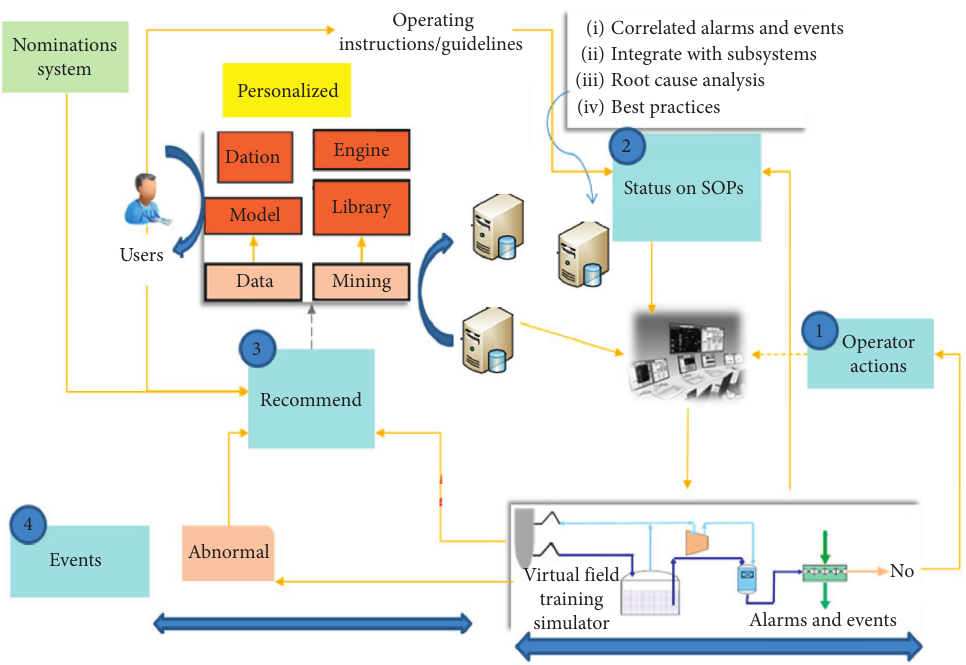
Figure 1: Personalized recommendation algorithm collection